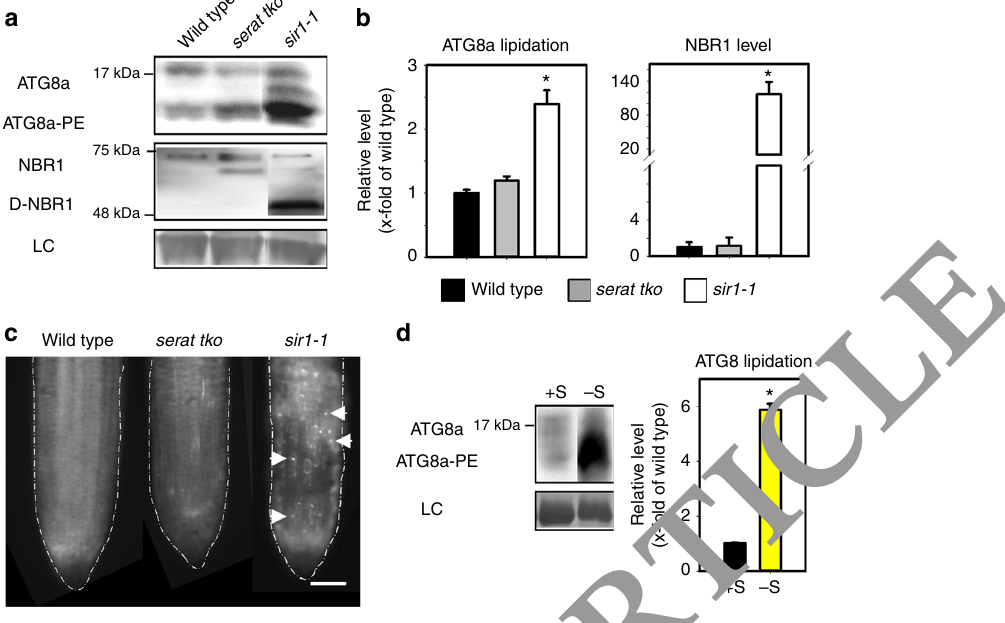
Fig. 5 Autophagy is speci fi cally induced by limited S-precursor supply for cysteine biosynthesis. a Autophagy induction in the shoot of serat tko and sir1-1 was determined by immunological detection of the canonical autophagy marker ATG8a and NBR1 with speci fi c antisera. Lipidation of ATG8a (ATG8a-PE) (apparent size: 15 – 20 kDa) is essential for autophagosome formation and indicated by a signi fi cant shift during electrophoresis. NBR1 is a cargo receptor for selective autophagy and consequently degraded in autophagic bodies (D-NBR1) (apparent size: 50 – 75 kDa). b Level of ATG8a-PE and D-NBR1 shown in a were quanti fi ed ( n = 3, mean ± s.e.m., one-way ANOVA, * p < 0.05). c Autophagy induction in the root of serat tko and sir1-1 was detected by MDC staining. White arrows marked the visible autophagic bodies. Scale bar, 25 µ m. d Autophagy induction in the shoot of WT under sulfur de fi ciency was determined by ATG8a-PE level ( n = 3, mean ± s.e.m., t -test, * p <